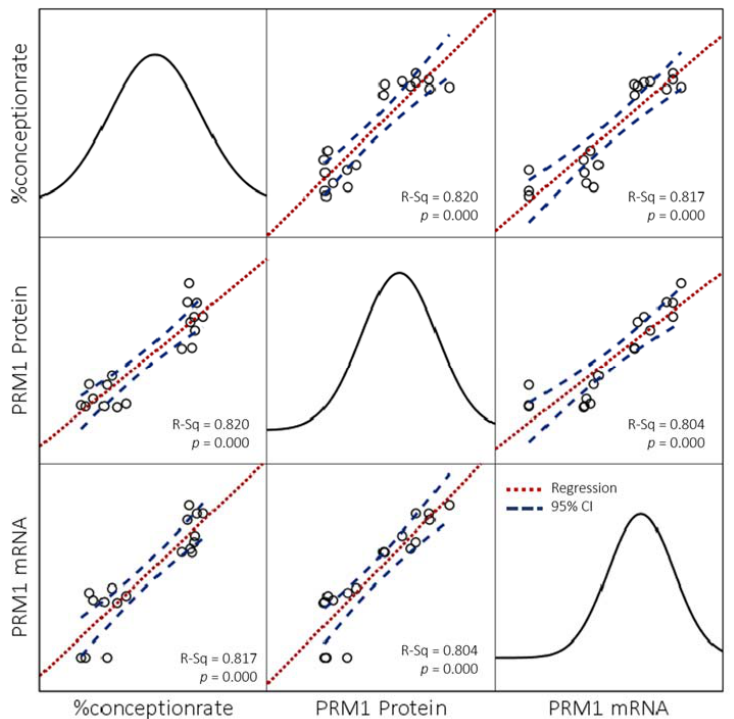
Figure 4. Scatter plot matrix graph of the linearity relationship between %CR and relative abundance of gene and protein of PRM1 in bulls regardless of bull grouping based on breed and fertility.